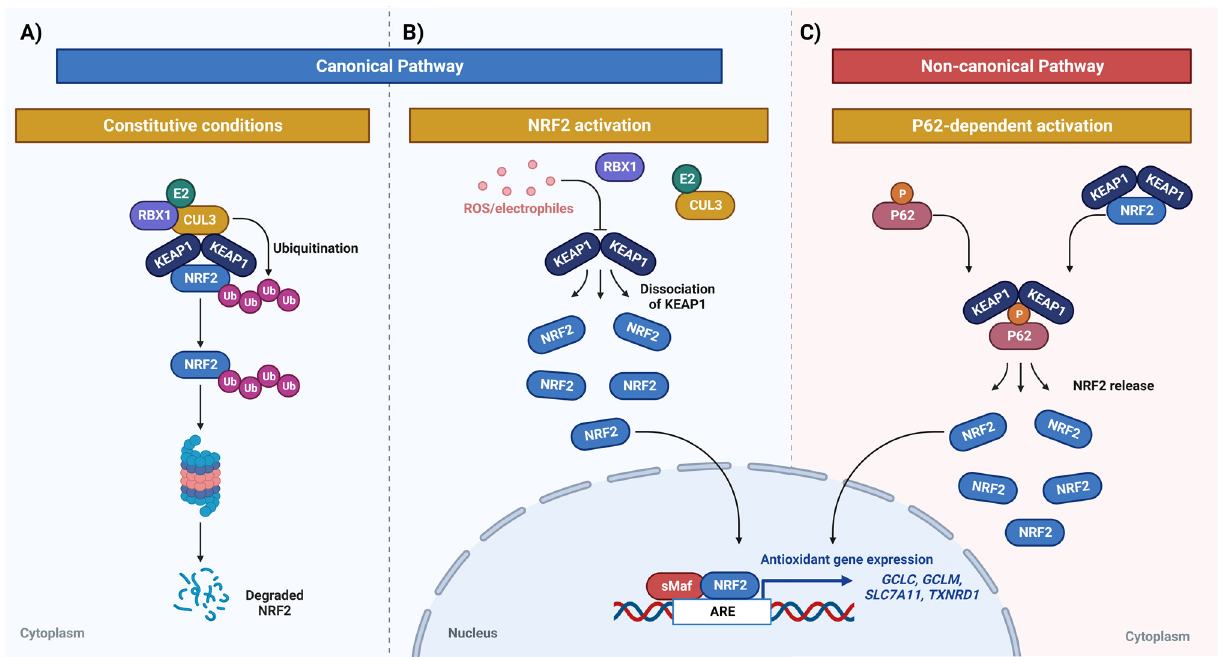
Figure 1. Canonical and non-canonical NRF2 pathways. ( A ) NRF2 proteasomal degradation under constitutive conditions. The ETGE and DLG motifs of NRF2 bind to the KEAP1 Kelch domains; this binding causes the ubiquitin ligase CUL3/RBX1 E2 to join the complex, in which CUL3 acts as a scaffold protein that binds to the BTB domain of KEAP1, allowing the formation of a complex with a ubiquitin-conjugating enzyme (E2). ( B ) Under oxidative and/or electrophilic stress, KEAP1 undergoes a conformational change, which interrupts the Kelch/DLG binding and leads to its detachment from NRF2, thus the degradation of NRF2 is interrupted and it translocates to the nucleus. ( C ) Non-canonical pathway of P62-mediated NRF2 activation. When autophagic flux is compromised and P62 accumulates, KEAP1 is sequestered by P62 and does not bind to NRF2, stopping its degradation. Created with